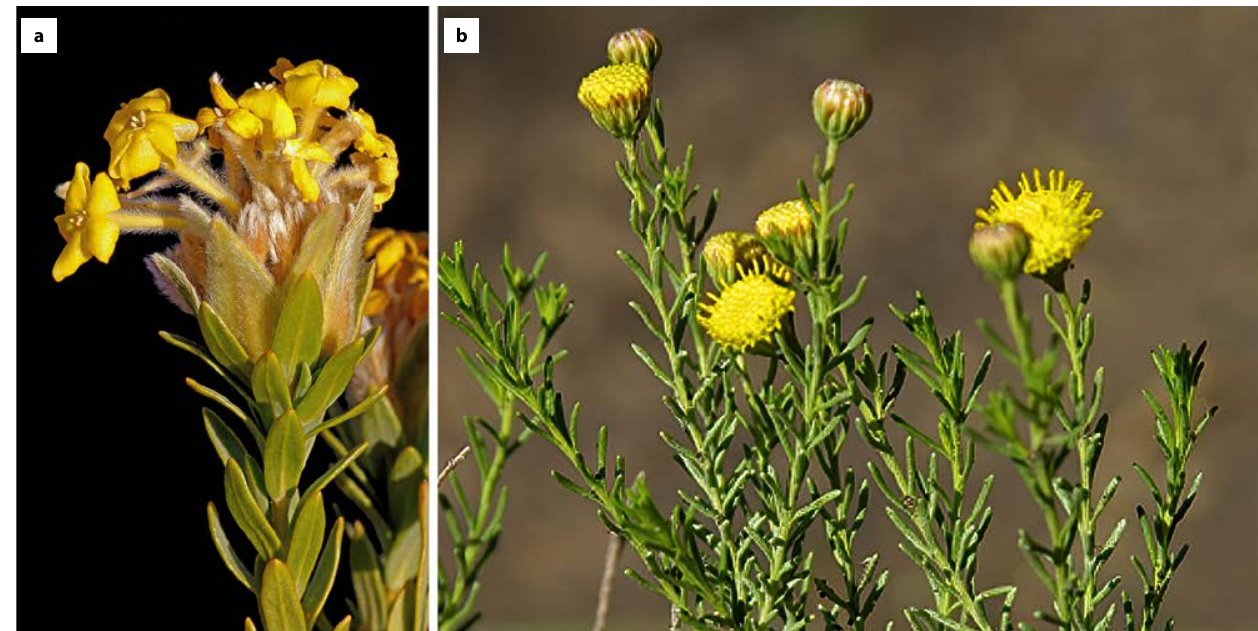
Figure 6: (a) Lasiosiphon burchellii (= Gnidia burchellii ) and (b) Chrysocoma ciliata (= C. tenuifolia ) Photographs: P.C. Zietsman (a) & C.J.